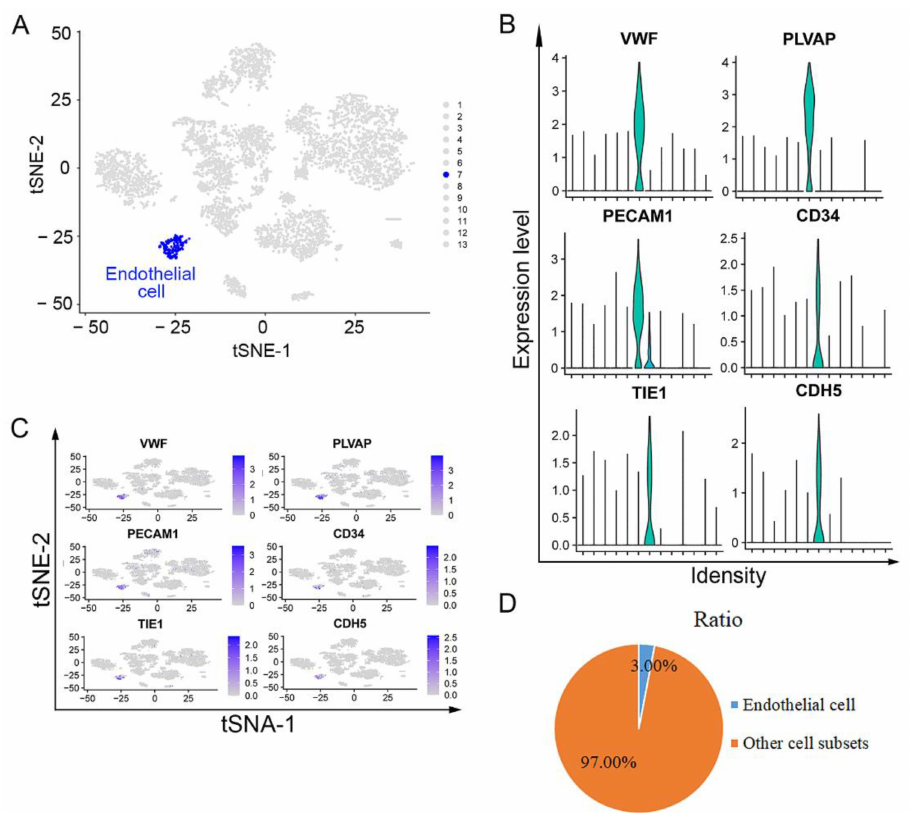
Figure 2. Gene profile of endothelial cells in human lower ESCC with scRNA sequencing: ( A ) tSNE map of total 6262 high-quality cells and the cluster visualization of endothelial cells; blue dots: endothelial cells. ( B ) expression levels of VWF , PLVAP , PECAM1 , CD34 , TIE1 , and CDH5 in 6262 cells illustrated as Violin plots; and ( C ) tSNE map; ( D ) ratio of endothelial cells and other cell